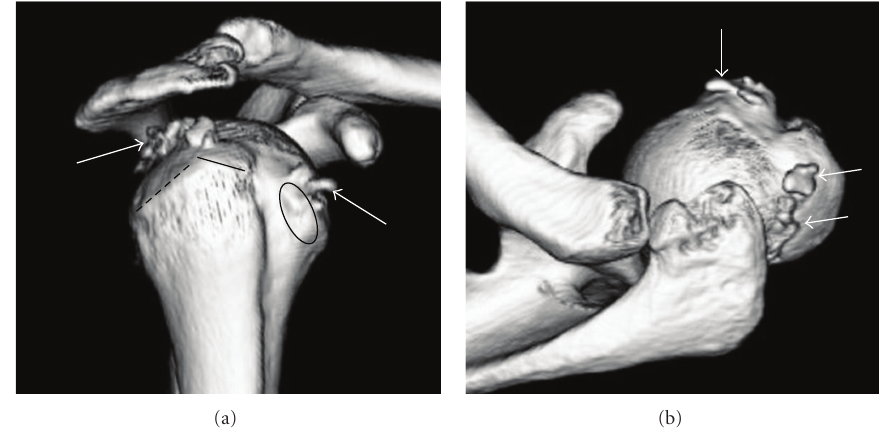
Figure 2: (a) and (b) Three-dimensional computed tomographs showing calcific deposits at the lesser tuberosity and the middle facet of the greater tuberosity. White arrows indicate the presence of calcific deposit. Solid line: superior facet, broken line: middle facet, circle: lesser